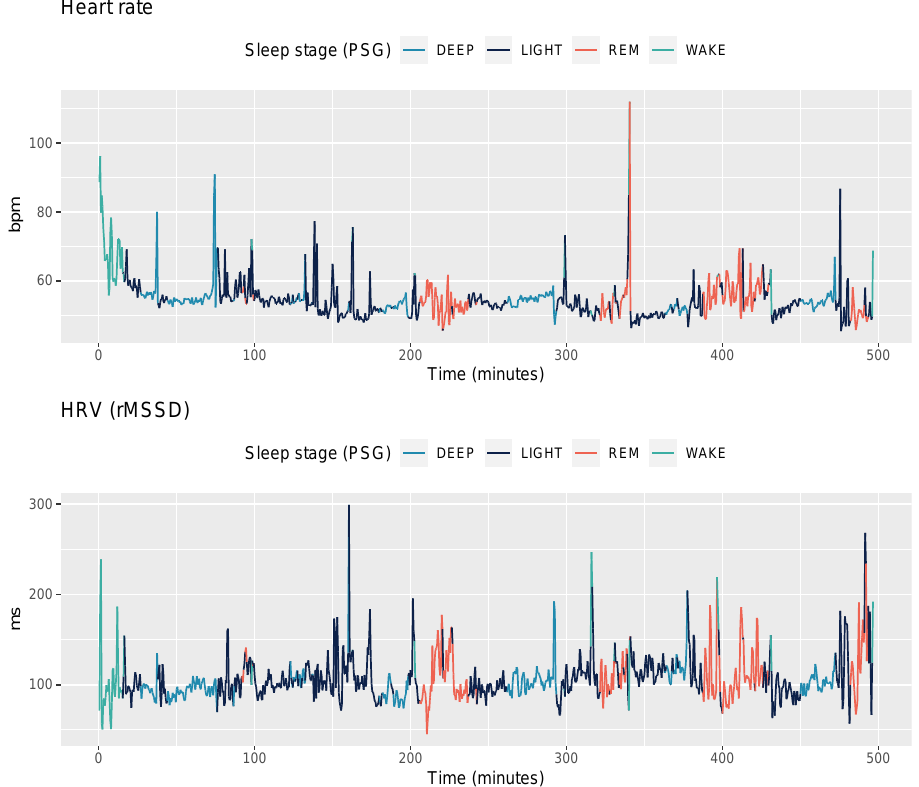
Figure 3. Heart rate and HRV (rMSSD) data for one participant (Dataset 1: Singapore, 15 years old) and one night. Sleep stages annotated from PSG data are